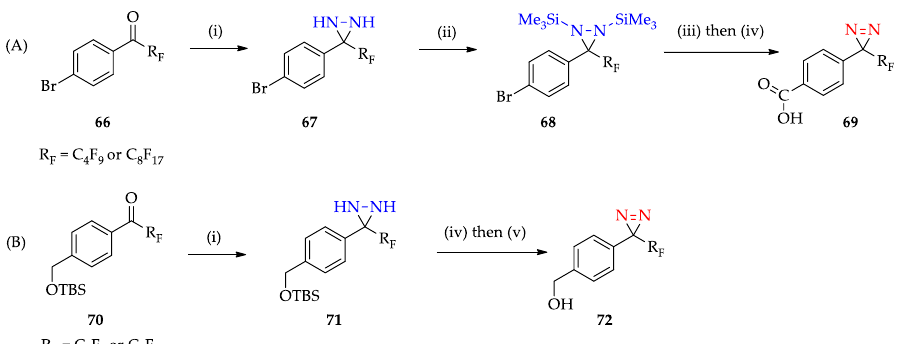
Figure 9. Perfluoroalkylated aryldiazirine synthesis: ( A ) perfluorobutyl and perfluorooctyl residue 69 . ( B ) perfluoropropyl and perfluorohexyl residue 72 . Conditions: (i) 1. NH 2 OH.HCl, pyridine, EtOH, 60 °C or 85 °C, 2. p- TsCl, DMAP, Et 3 N, CH 2 Cl 2 , 0 °C to r.t., 3. NH 3 (l), CH 2 Cl 2 or EtOH, −78 °C